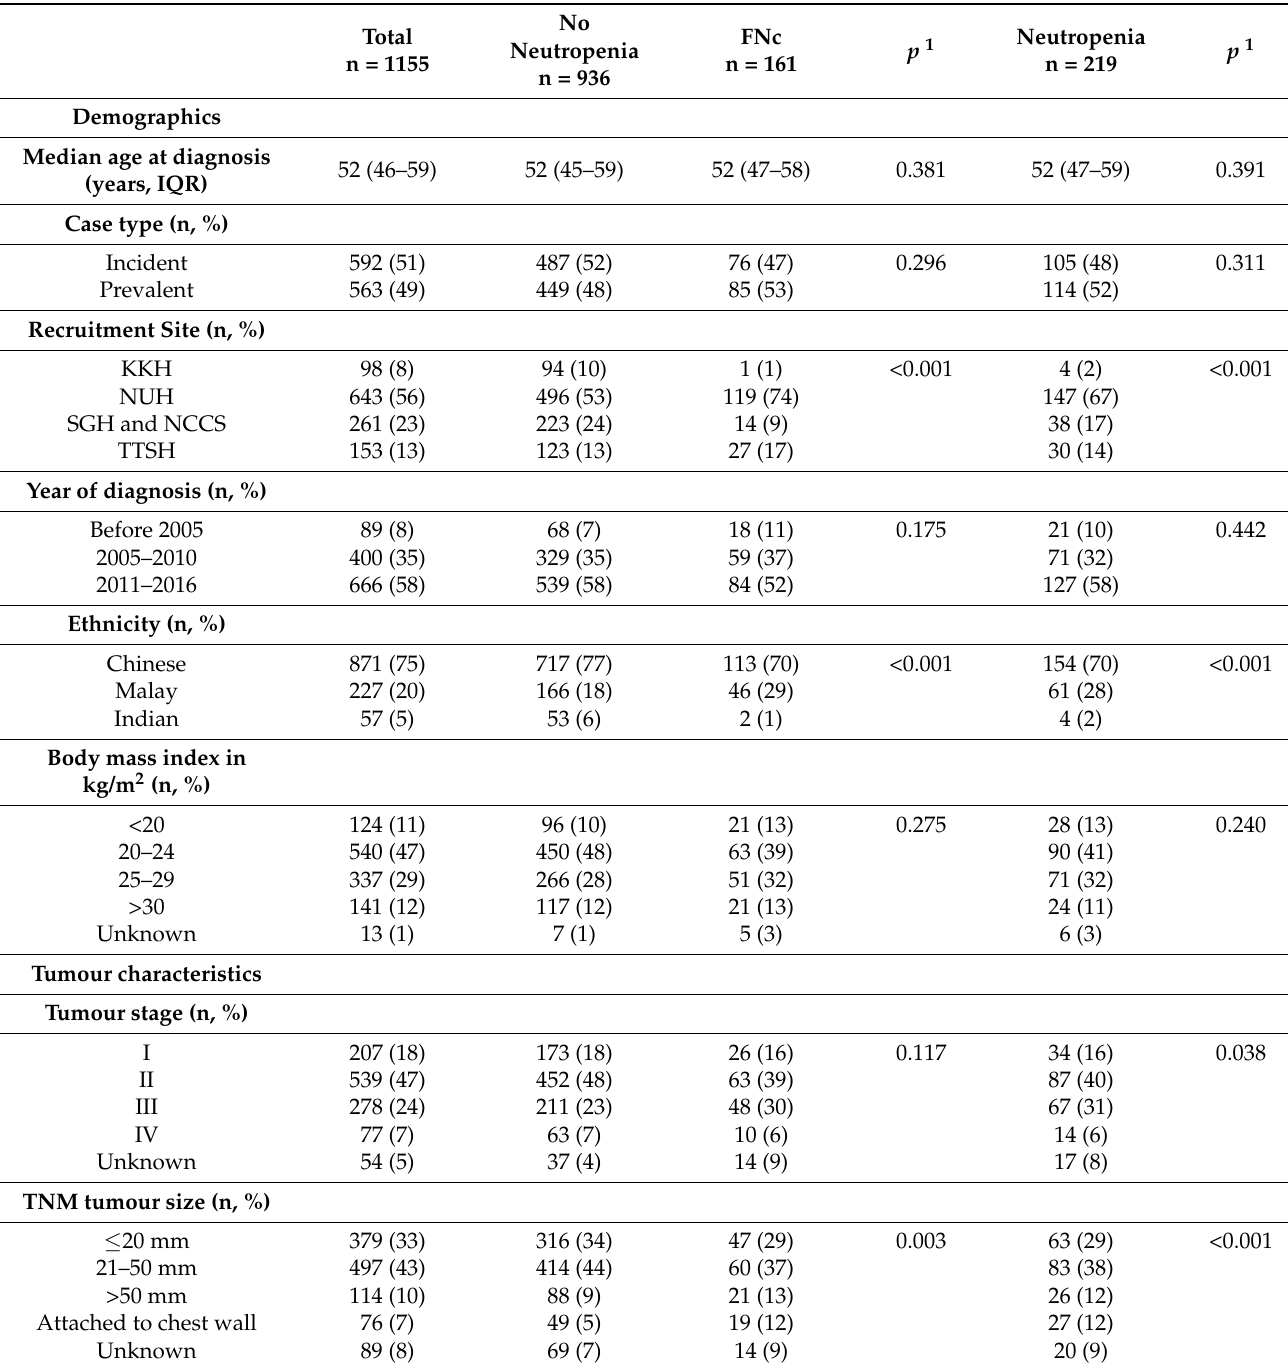
Table 1. Description of the analytical cohort of breast cancer patients treated with chemotherapy. 1 Comparison with controls who did not develop neutropenia using Kruskal–Wallis test for continu- ous variables, and Chi-square test for categorical variables. FNc: febrile neutropenia from initiation of chemotherapy treatment (using taxanes or anthracyclines) to 30 days from last chemotherapy treatment cycle (i.e., within 30 days of last chemotherapy treatment); IQR: interquartile range; KKH: KK Women’s and Children’s Hospital; NUH: National University Hospital; SGH: Singapore General Hospital; NCCS: National Cancer Centre Singapore; TTSH: Tan Tock Seng Hospital; HER2: